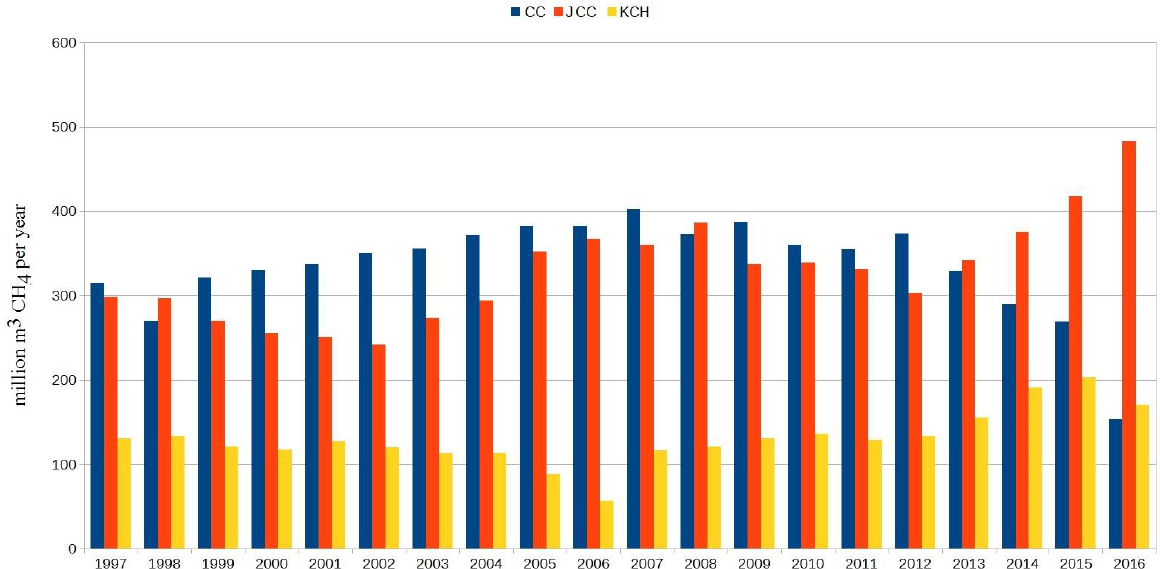
Fig. 7. Absolute methane emissions for the coal companies